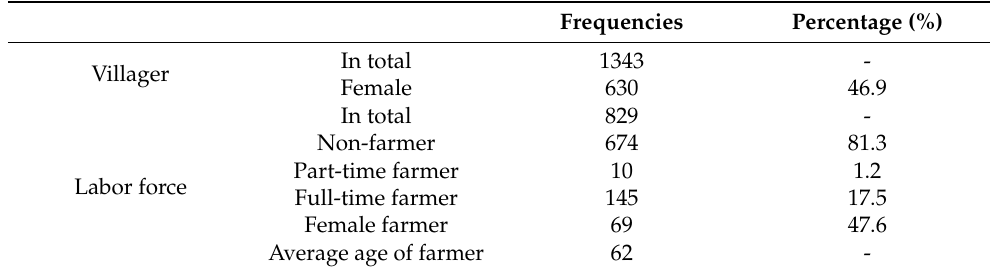
Table 1. Overview of Huang village in